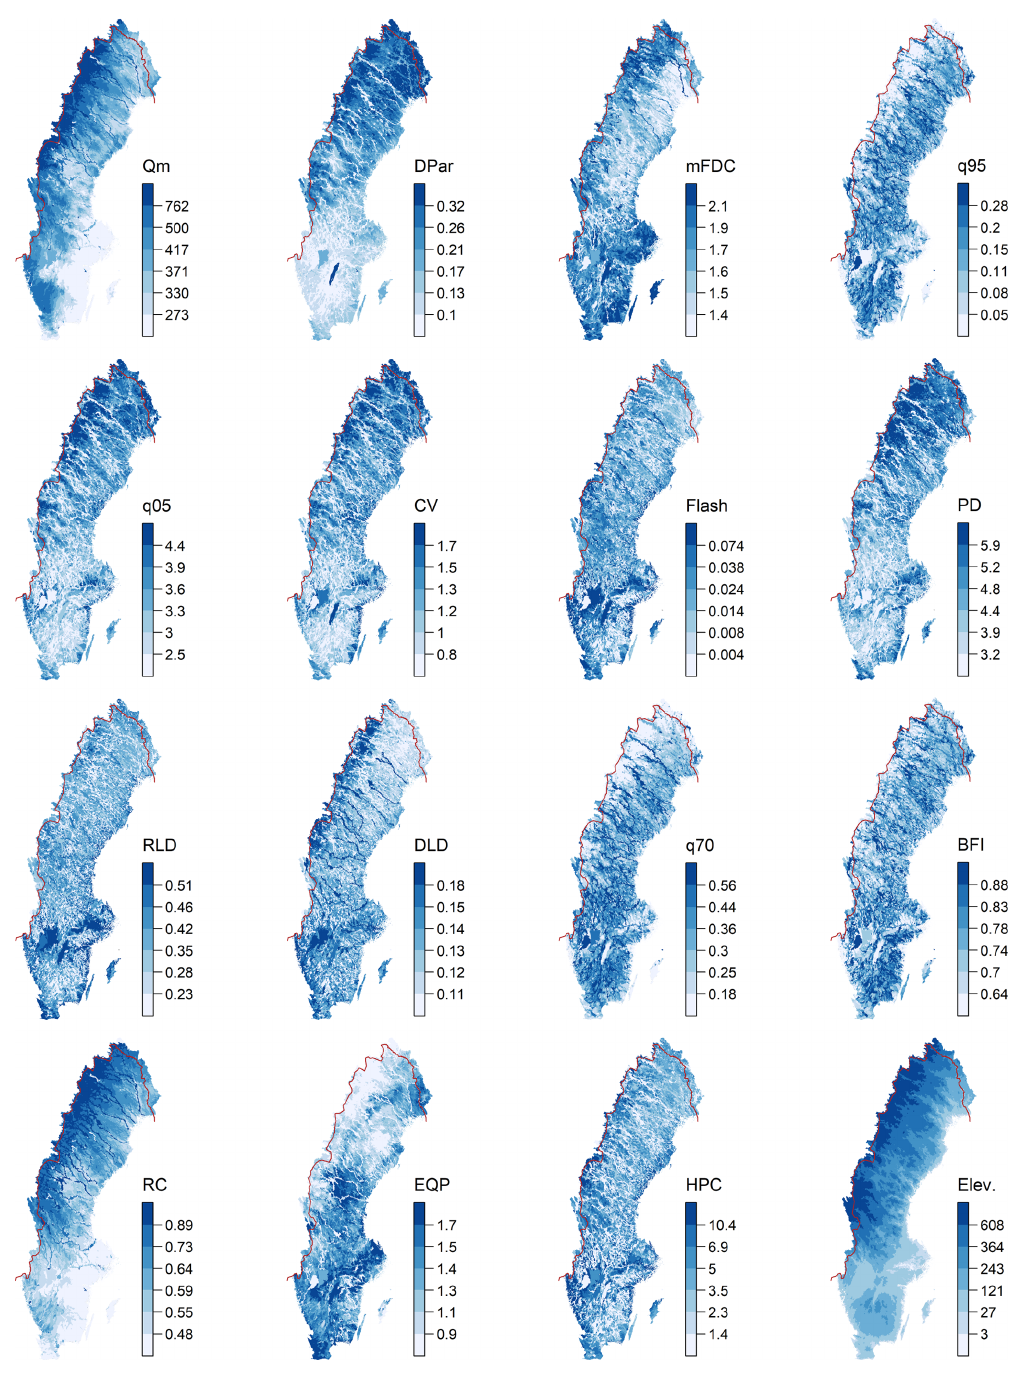
Figure C1. Spatial variability of the 15 modelled hydrological signatures including the catchment mean elevation. The colour intervals are based on the quantiles (15% intervals) of each signature (and elevation) distribution. A clarification of the abbreviations used here can be found in Table 1 in the main